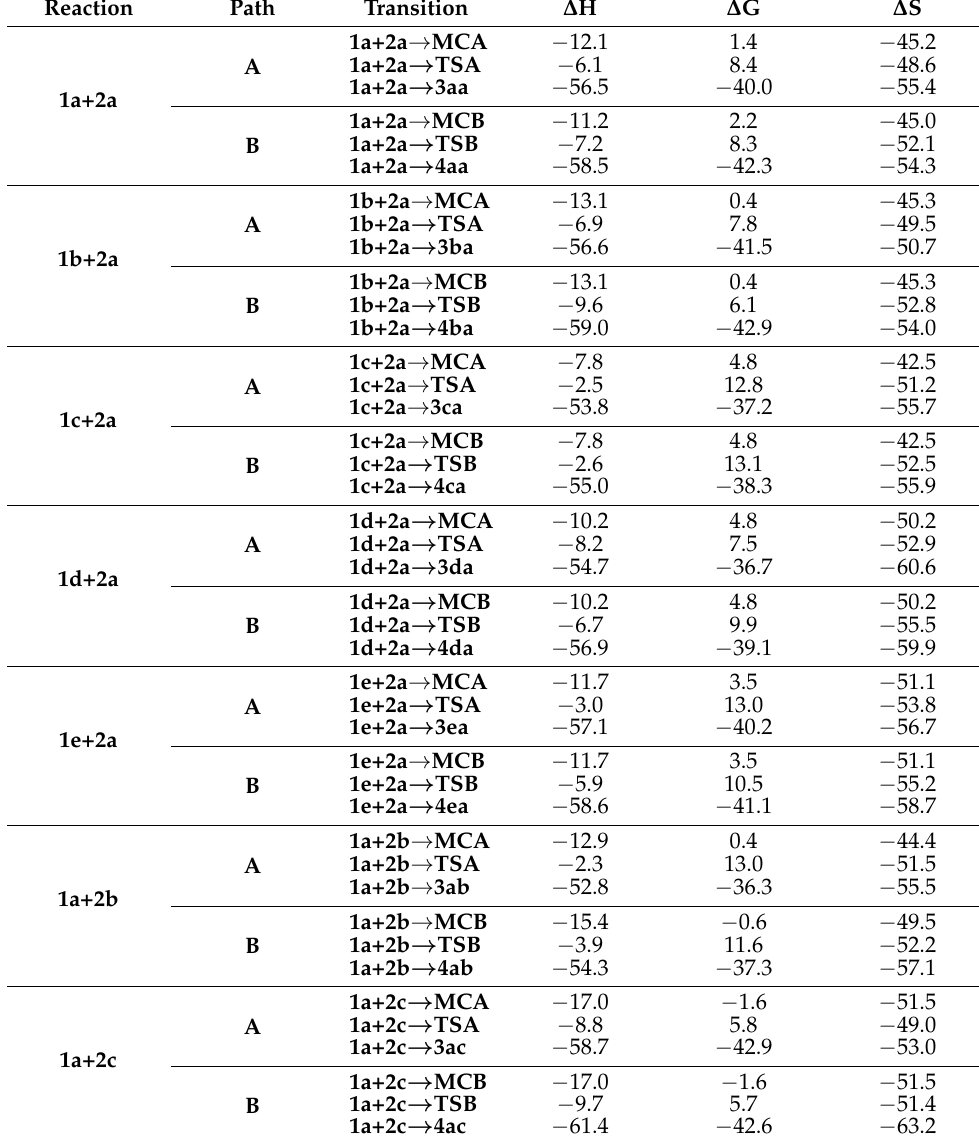
Table 2. DFT kinetic and thermodynamic parameters for the 32Cas of diarylnitrylimines 1a – e and ACNs 2a – c in toluene ( ∆ H, ∆ G are in kcal/mol; ∆ S are in cal/mol · K). Reaction Path